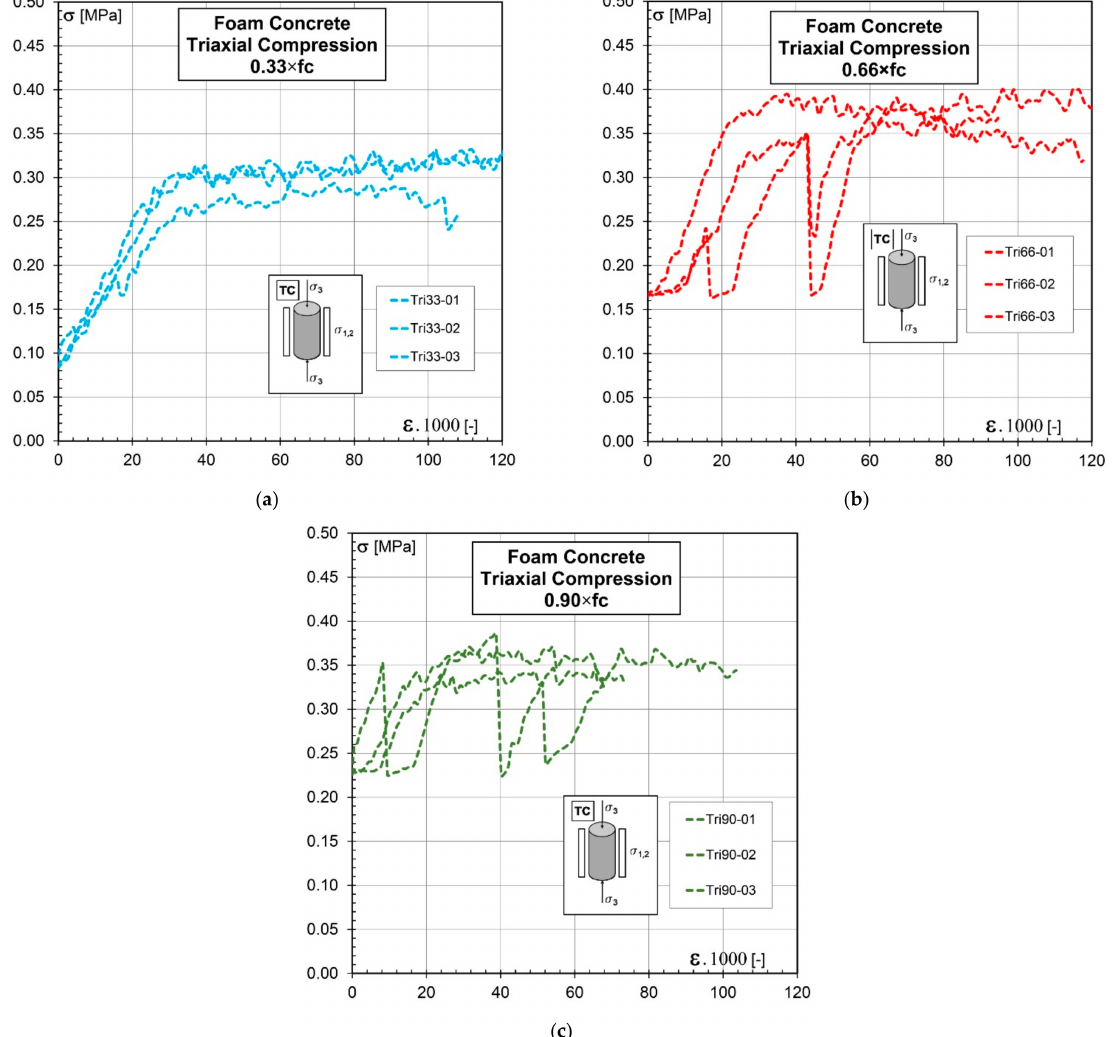
Figure 11. Stress–strain curves of TC tests: ( a ) 33% × f c , ( b ) 66% × f , and ( c ) 90% × f c